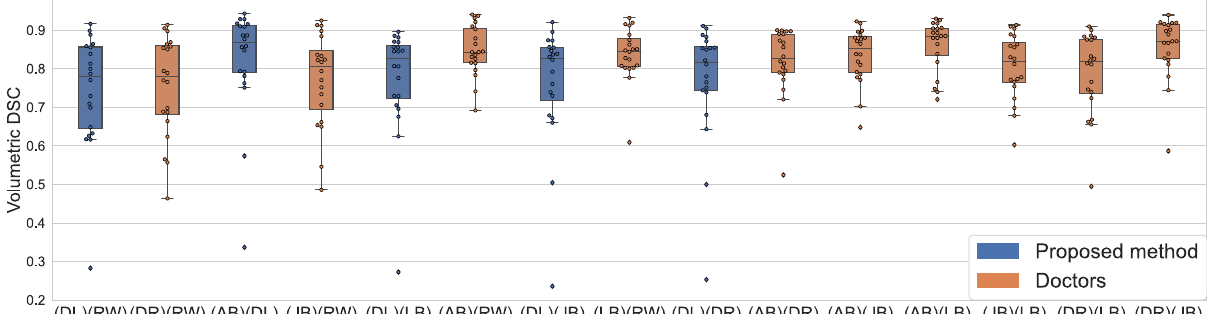
Fig. 6 Method performance vs interobserver variability. Quantitative segmentation performance and interobserver variability is measured using volumetric DSC across comparison pairs obtained on 20 NSCLC patients. DR1, DR2, DR3, DR4, and DR5 — represent contours made by the doctors (expert clinicians), DL — represents automatically generated contours. Orange box plots correspond to manual segmentation vs manual segmentation comparison and display interobserver variability. Blue box plots correspond to the proposed method vs manual segmentations comparisons and display the proposed method performance. Data were presented as box plots with overlaid swarm plots, where boxes are representing the interquartile range (IQR), extending from Q1 to Q3 and centered on the median value. Upper whiskers represent the highest data point that is less than Q3 + 1.5 × IQR. Lower whiskers represent the smallest data point that is greater than Q1 − 1.5 × IQR. Data points outside whiskers are considered